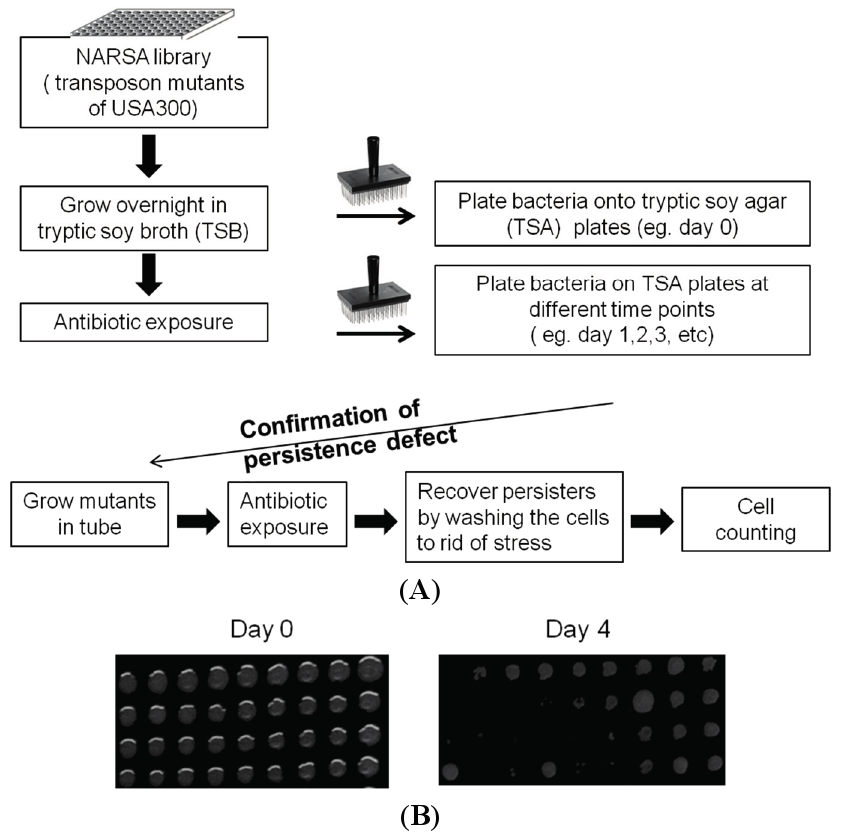
Figure 1. ( A ) Work flow for isolation of mutants with defect in persistence. The S. aureus USA300 transposon library from NARSA was grown in tryptic soy broth for 16 h to reach stationary phase. Rifampicin was added to the stationary phase culture at 2 μ g/mL (>10× MIC). Before rifampicin exposure, bacteria were stamped onto tryptic soy agar plates (TSA) using a 384-pin replicator as the input control. Over the course of a 4-day antibiotic exposure, bacteria were washed and plated onto TSA plates daily and all mutants that showed defective growth was recorded and tallied until Day 4; ( B ) Representative agar plate images with mutant library after the 4-day rifampicin exposure where some mutants show defect in